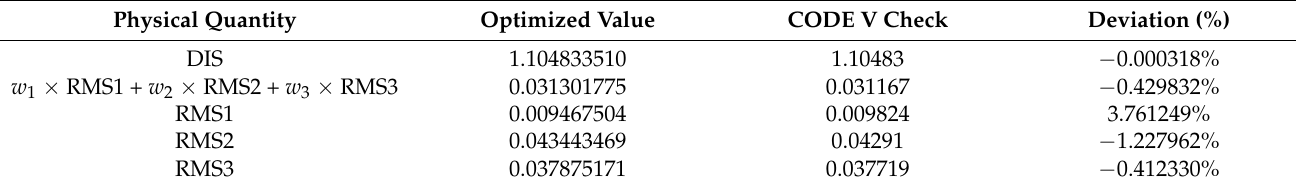
Table 6. Checking optimization